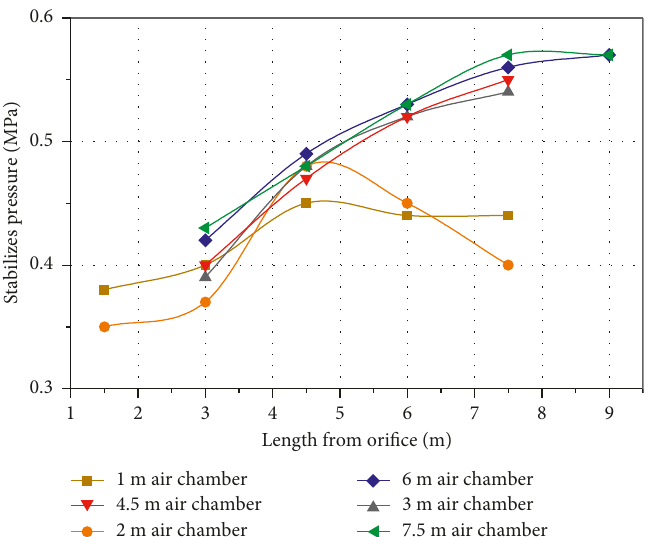
Figure 11: Stable pressure change plot for different sealing positions of the drilled hole.